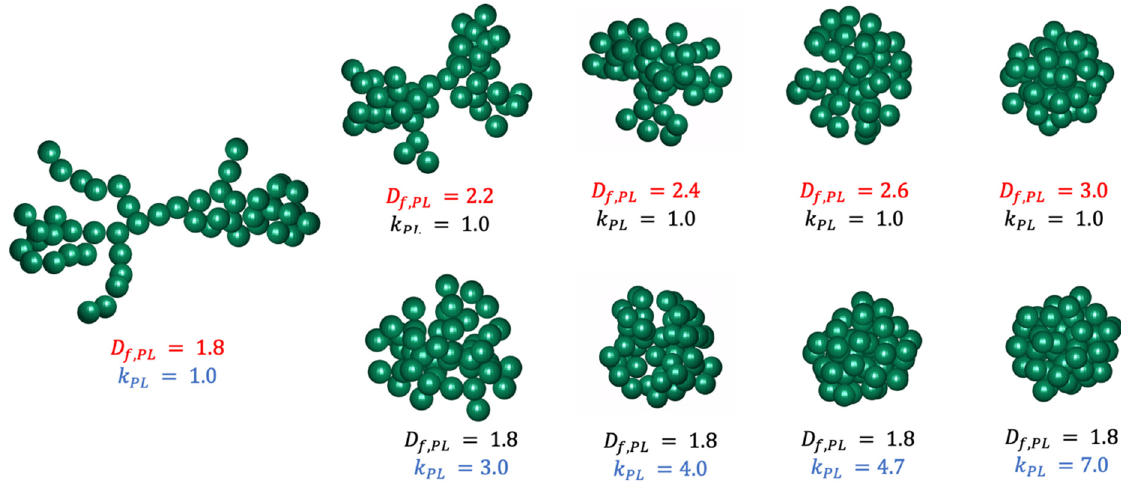
Figure 4. Morphological properties of aggregates with different D f , PL and k PL .